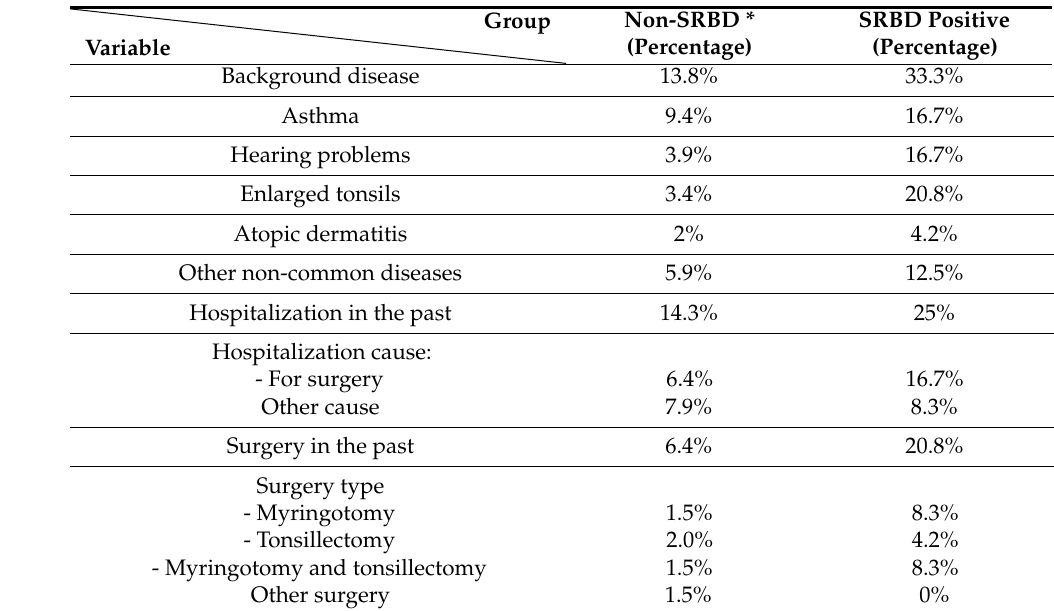
Table 2. Children general health